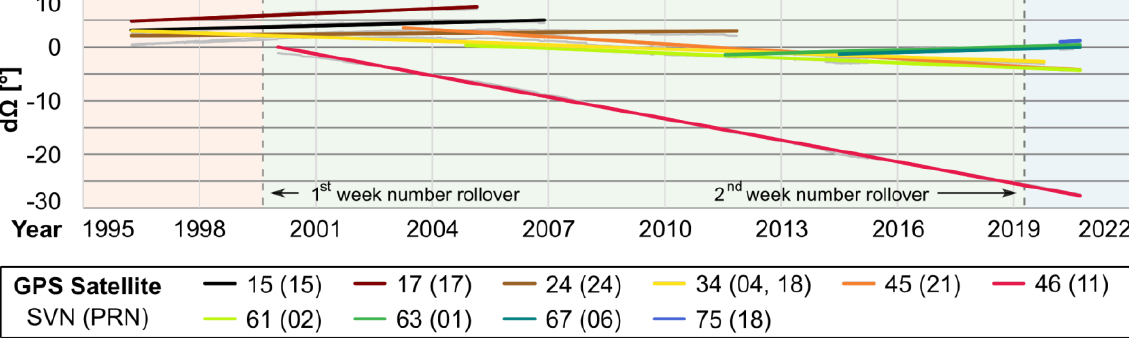
The results of the analysis indicate that the magnitude of the satellite AN separation The comparison of the separation rate of all analyzed satellites is shown in Figure 7.